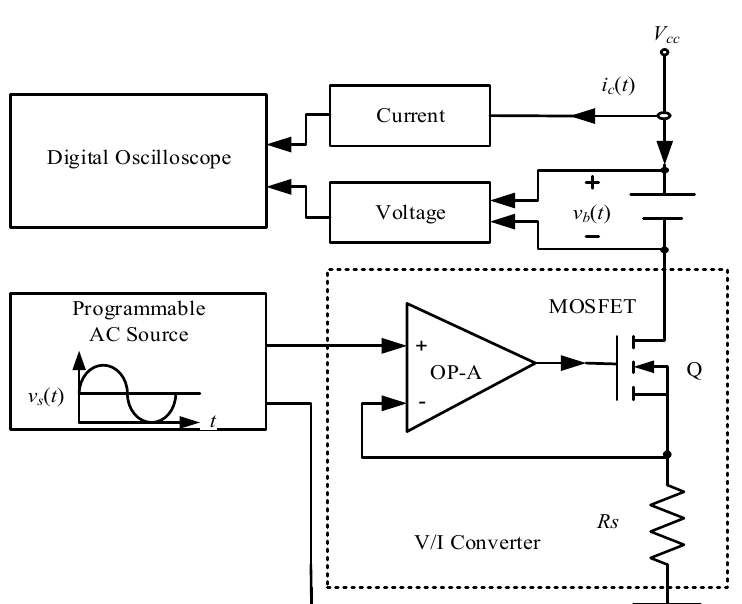
Figure 5. The battery SOC test